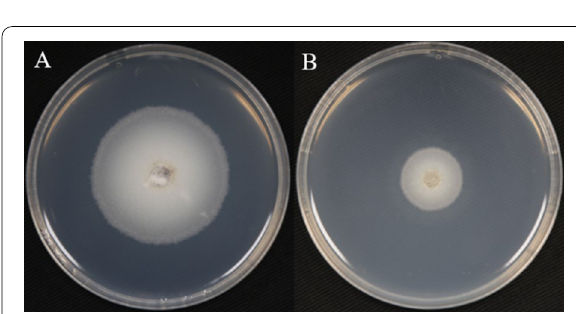
Fig. 2 Inhibitory effect of volatile metabolite of EBS03 on V. dahliae . A control; B treated with EBS03